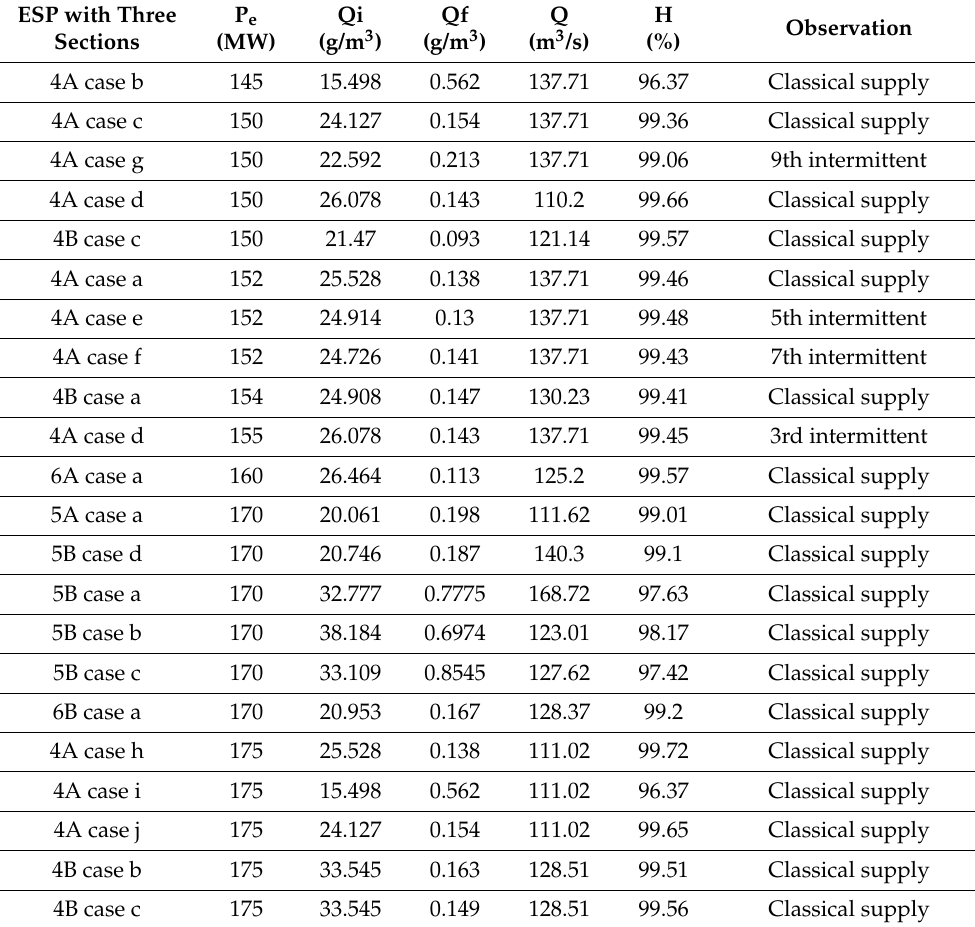
Table 16. Experimental measurements for ESPs with three sections